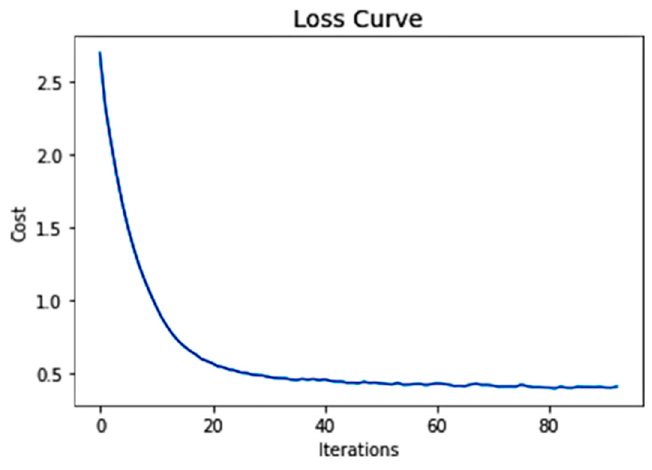
Figure 4. Loss Figure 4. Loss curve.